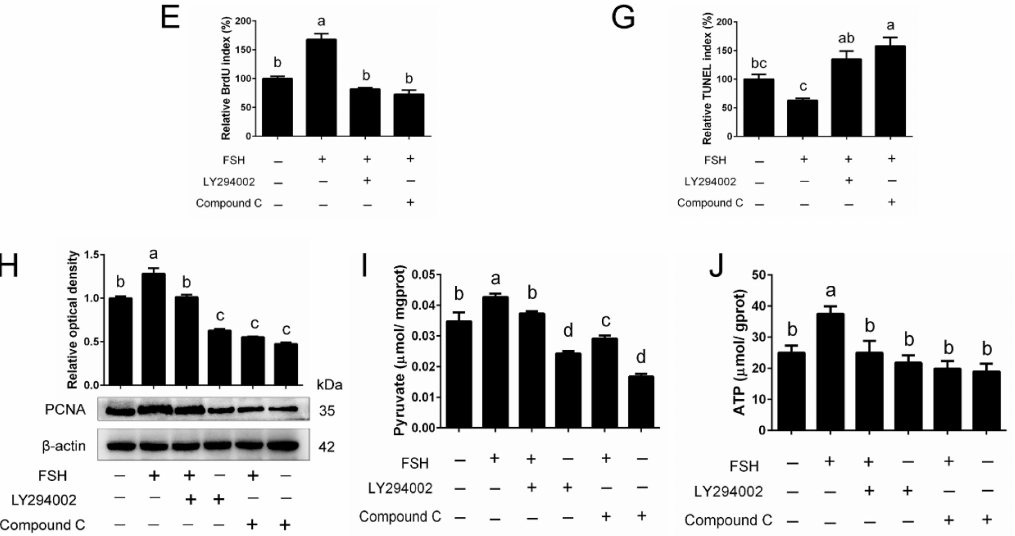
Figure 9. Improved effect of FSH on chicken ovarian aging was inhibited by the blockage of AKT and AMPK signaling. ( A , B ) Ovarian tissues of D580 hens were treated with FSH, FSH + LY294002, FSH + Compound C, LY294002, or Compound C for 72 h, respectively. The expression of p-AKT, AKT, p-AMPK, and AMPK was determined by Western blotting. ( C ) Representative H&E staining of ovaries. Scale bar: 200 µ m. ( D – G ) BrdU incubation and TUNEL labeling of ovaries that were treated as indicated. Scale bar: 50 µ m. ( H ) Level of PCNA in ovaries treated as indicated. ( I , J ) Pyruvate and ATP content of